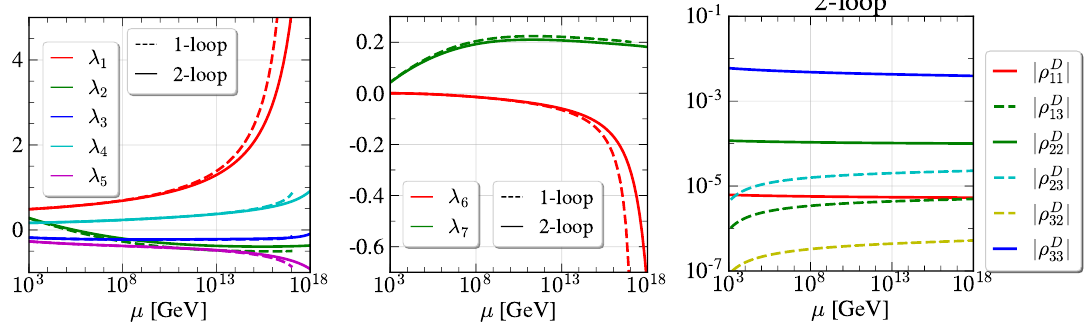
Figure 12 . Evolution of the parameter point in eq. (3.10) with an aligned Yukawa sector, a U = 0 : 8, a D = a L = cot (cid:12) (cid:25) 0 : 4.